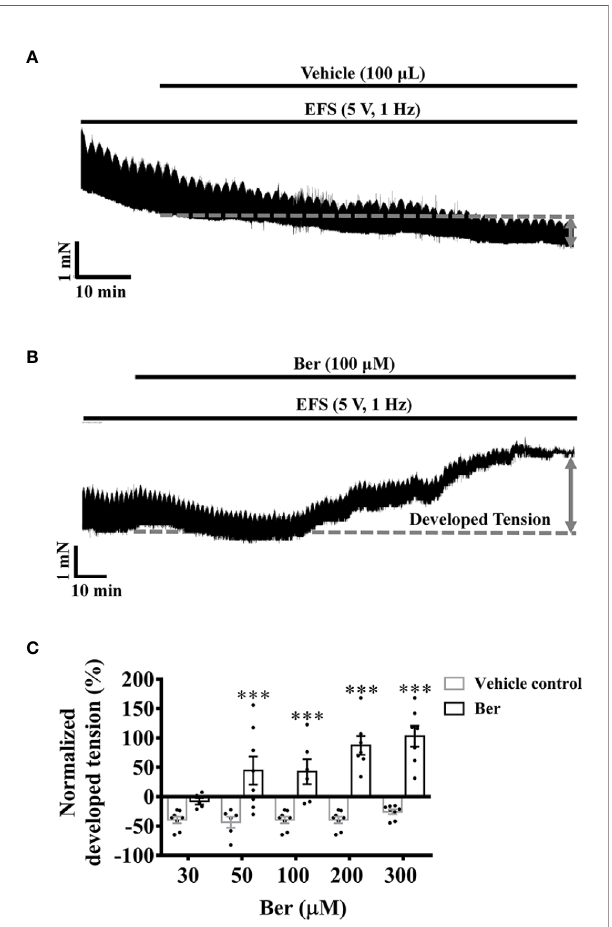
FIGURE 4 | Berberine increased the tension of the electrical fi eld stimulation (EFS )- paced left ventricular muscle (LVM) strips . (A, B) Original isometric tension recordings showing that berberine (100 µM) increased the tension of the EFS-paced LVM strips (5 V, 1 Hz). (C) Summary data indicating that berberine increases the tension of the EFS-paced LVM strips in a concentration-dependent manner. The numbers of repeats are as follows: 30 µM Ber, n = 5, N = 5; 50 µM Ber, n = 8, N = 8; 100 µM Ber, n = 6, N = 6; 200 µM Ber and 300 µM Ber, n = 7, N = 7; n and N are the numbers of LVM strips and rats, respectively. Ber stands for berberine. ***p < 0.001 vs. vehicle control group; two-way ANOVA with Sidak's multiple comparisons